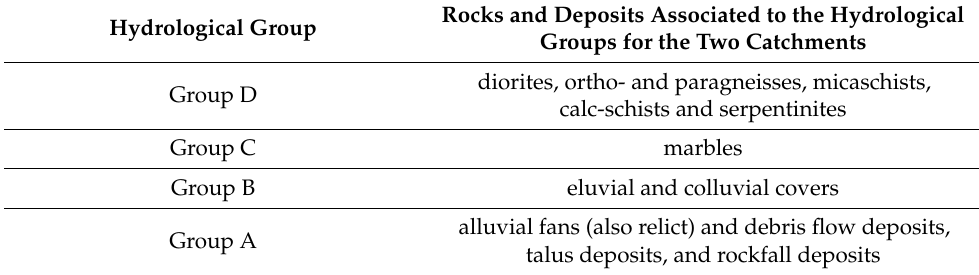
Table 1. Hydrological groups and related rock and deposit